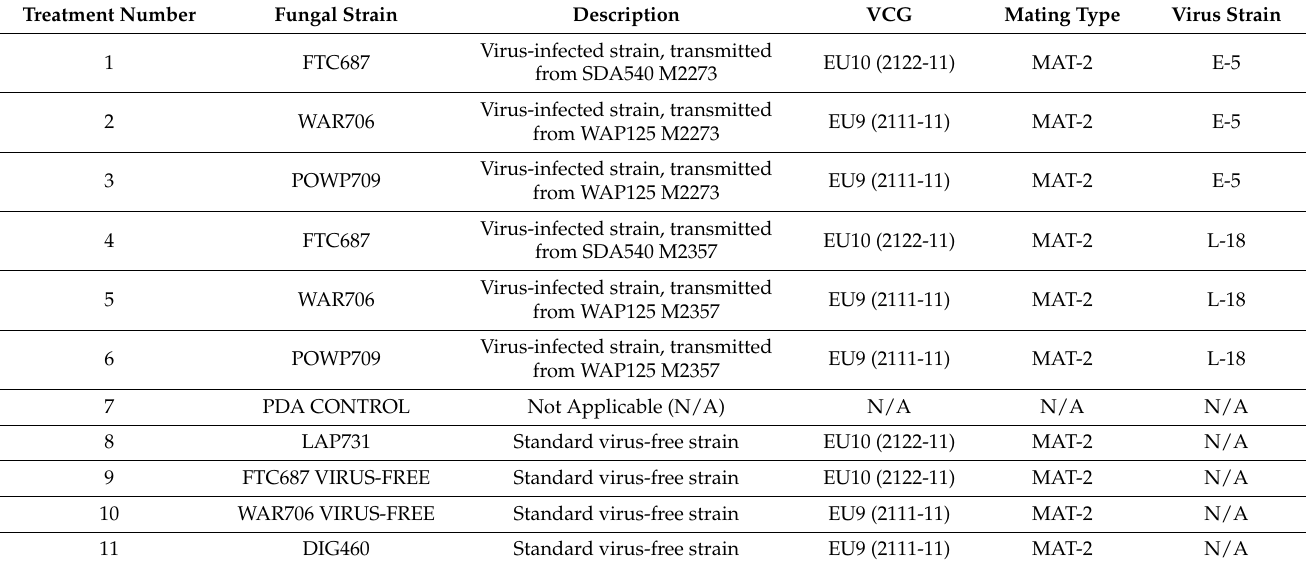
Table 1. Virus-infected and virus-free Cryphonectria parasitica strains used in this